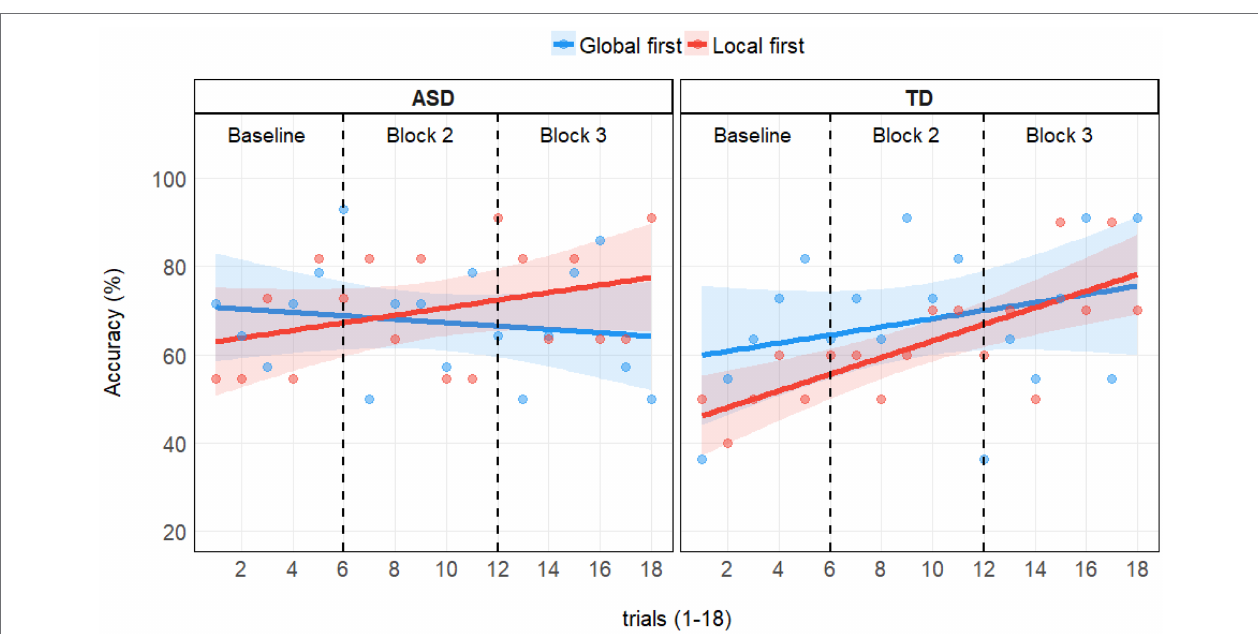
FIGURE 2 | Average accuracies per group (ASD left panel; TD right panel) for each trial (1–18) depending on priming condition order in the Embedded Figure Task (EFT). One point depicts the percentage of accurate responses per trial number in groups (ASD left panel; TD right panel) and condition orders (global first in blue; local first in red). Linear regression lines with confidence bands fitted per group and condition order combination. Black dashed lines illustrate the block limits: Trials 1–6 were baseline trials, which were followed by two blocks each with 6 trials that included global or local priming in a counterbalanced